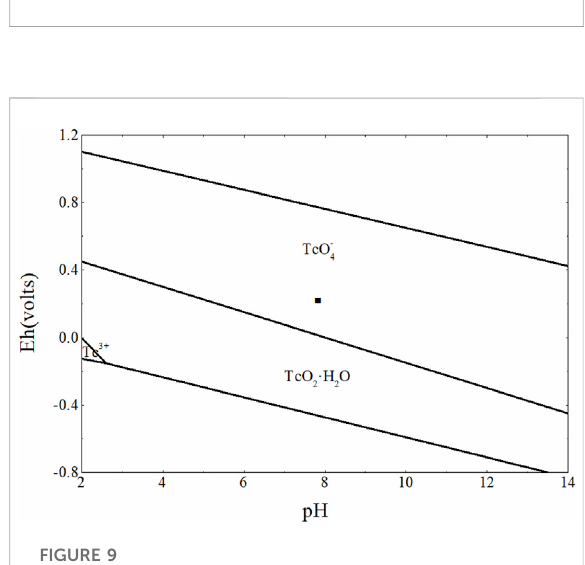
FIGURE 9 Eh-pH diagram of [Tc]tot = 10 − 4 mol L − 1 under the groundwater taken from the Gansu proposed-treatment plant